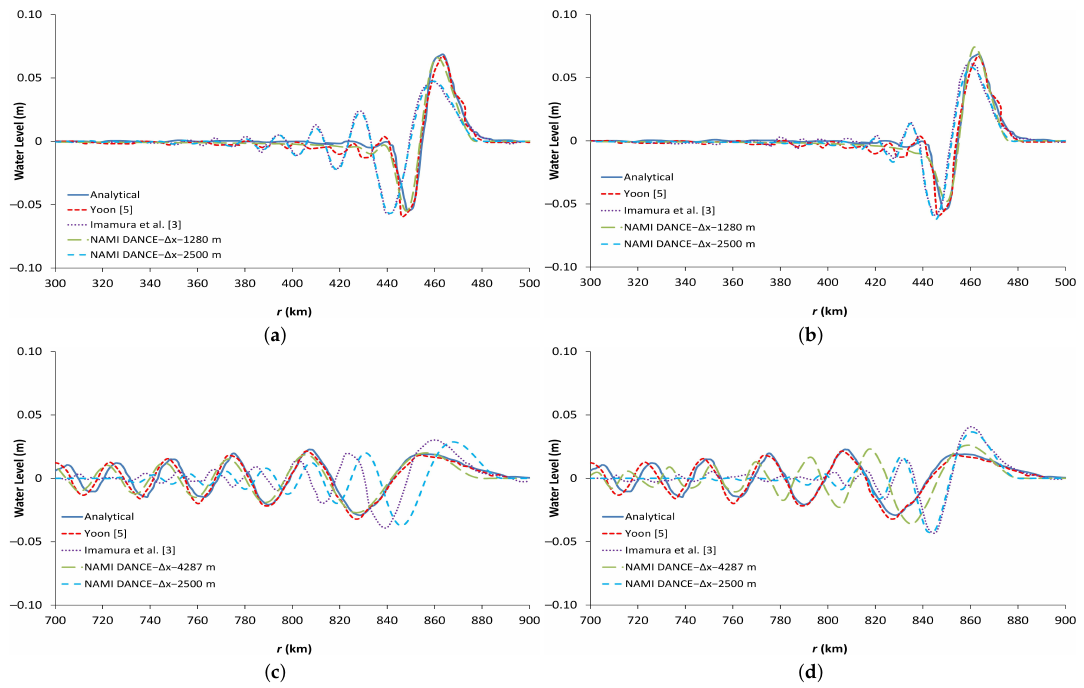
Figure 3. Comparison of water surface profiles of several numerical methods against the analytical solution of Carrier [27]: ( a ) h = 600 m and θ = 0 ◦ ,90 ◦ , ( b ) h = 600 m and θ = 45 ◦ , ( c ) h = 2100 m and θ = 0 ◦ ,90 ◦ , ( d ) h = 2100 m and θ = 45 ◦ . All comparisons are done at time 600 s for two different propagation axes and